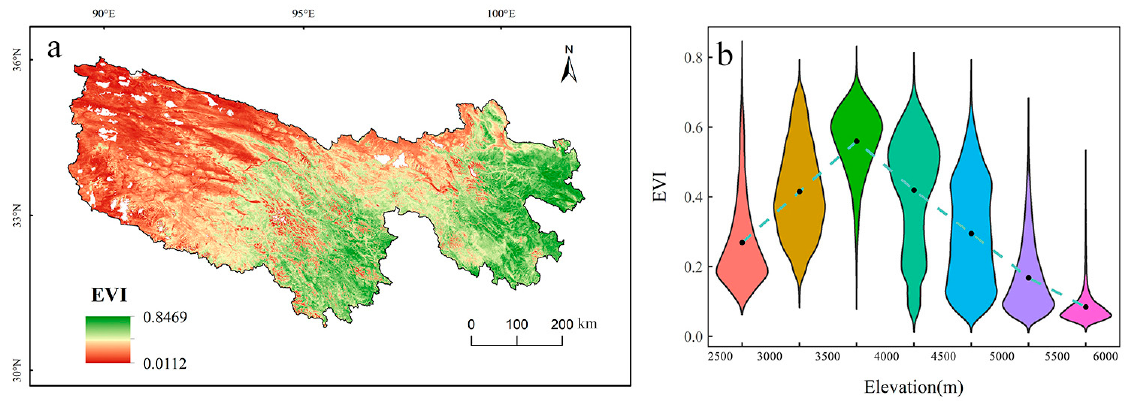
Figure 3. Distribution of annual mean EVI in the TRHR during 2000–2021: ( a ) spatially and ( b ) with elevation.